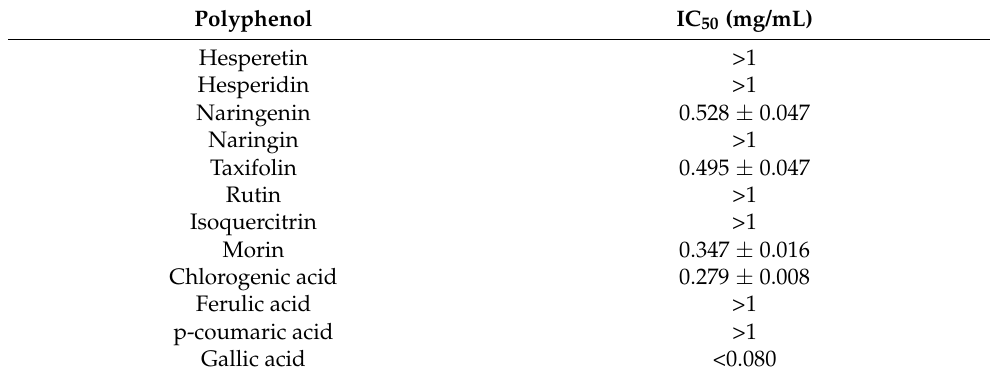
Figure 1. Formation of P. aeruginosa IBRS P001 biofilm after treatment with polyphenols. The error bars indicate standard deviations. The asterisks represent statistical significance *, p ≤ 0.05; **, p ≤ 0.01; ***, p ≤ 0.001, ****, p ≤ 0.0001, the data are presented as mean ± SD. Table 2. Cytotoxicity of examined compounds towards HaCaT cell line, represented as IC 50 (com- pound concentration that inhibited 50% of the cell growth) in